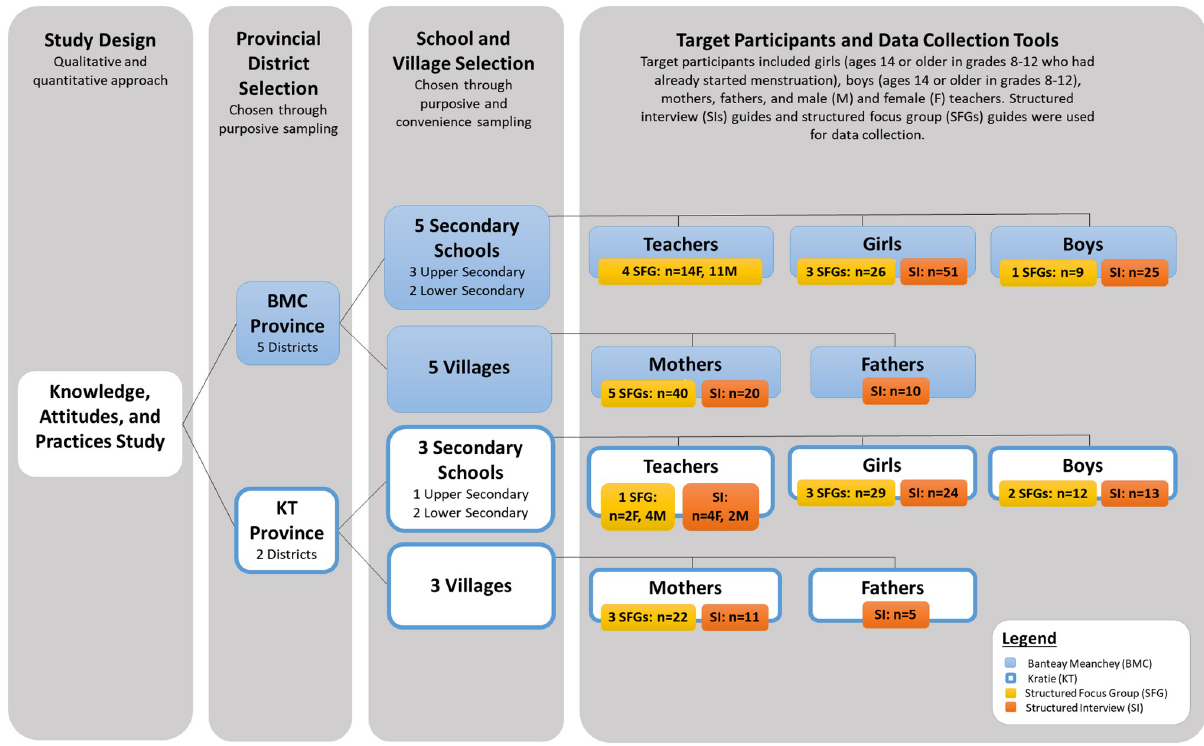
Fig 1. Study design overview. Diagram describing the study design process and final selection of study locations, participants, and participant numbers. Total number of participants: n = 334.